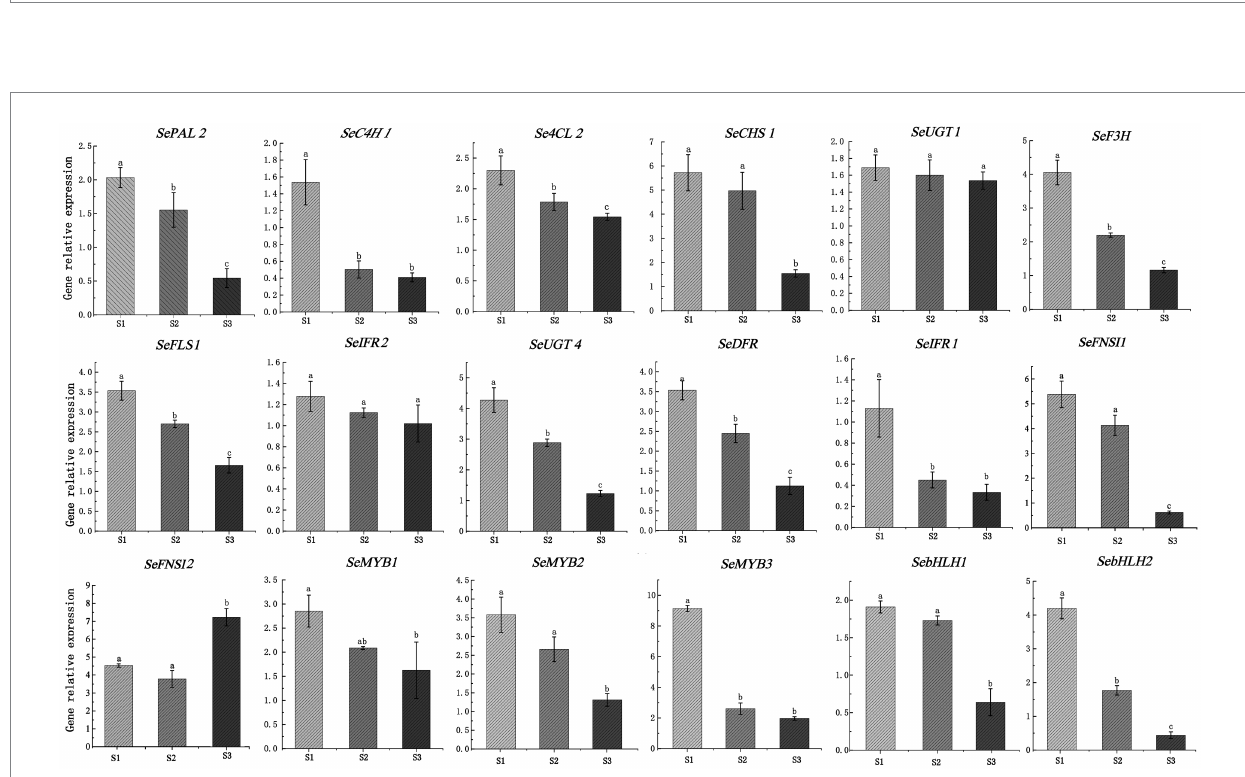
FIGURE 8 Validation of expression pattern of 18 DEGs associated with flavonoid synthesis using qRT-PCR. Relative expression levels of qRT-PCR were calculated using actin 7 as a standard. Three biological replicates and three technical replicates were obtained for each data point. Different lower-case letters indicate a significant difference among the different stages ( p < 0.05). PAL, phenylalanine ammonia-lyase; C4H, cinnamate-4-hydroxylase; 4CL, 4-coumarate-CoA ligase; F3H, flavanone 3-hydroxylase; FLS, flavonol synthase; IFR, isoflavone reductase; DFR, dihydroflavonol 4-reductase; FNSI, flavone synthase I; UGT,